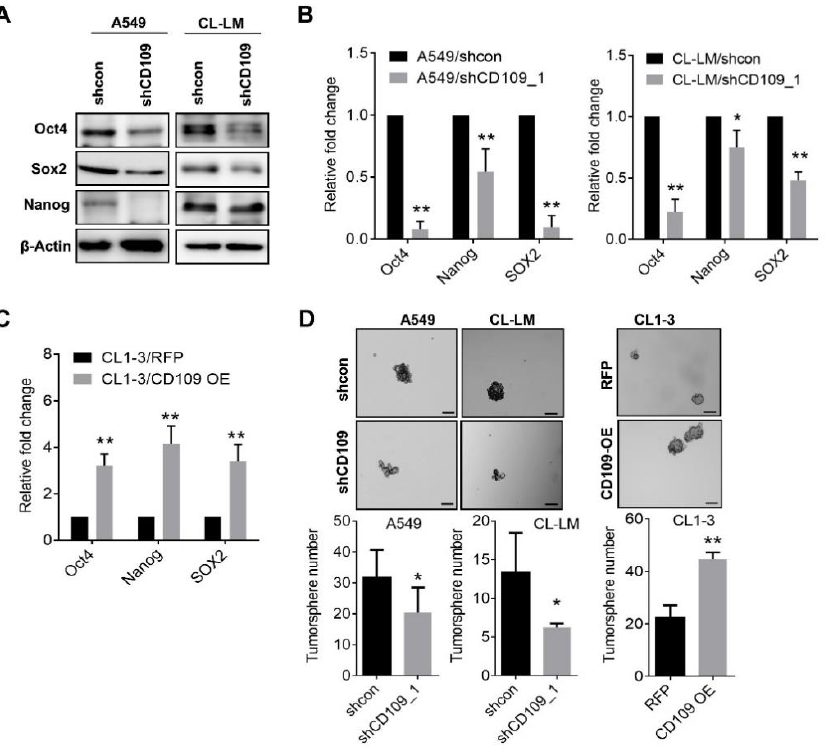
Figure 4. Expression of CD109 is associated with stemness properties. ( A ) Real-time PCR analysis of stem-like gene expressions in control and CD109-silenced A549 and CL-LM cells. ( B ) Western blot analysis of stem-like protein levels in control and CD109-silenced A549 and CL-LM cells. ( C ) Real-time PCR analysis of stem-like gene expressions in control and CD109-overexpressed CL1-3 cells. ( D ) Representative images of tumorsphere formation in CD109-silenced A549 and CL-LM cells (left panel) and CD109-overexpressing CL1-3 cells (right panel). Data were derived from three independent experiments, and results are expressed as the mean ± SD. * p < 0.05; ** p < 0.01, as determined by an unpaired t -test. Scale bar, 50 μm.